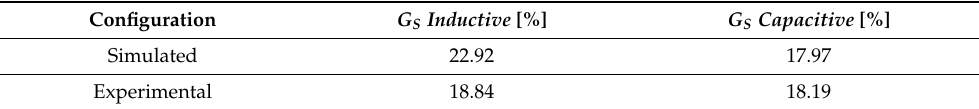
Table 12. Repowering error between values obtained in simulation and